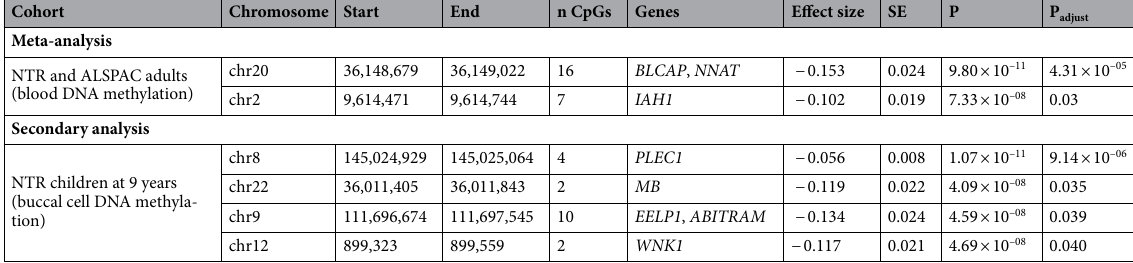
Table 4. Significant differentially methylated regions associated with left-handedness in meta-analysis and secondary analysis. Effect size is a weighted sum of the EWAS effects for each CpG site in the DMR (i.e. methylation differences between LH and RH) where the weights account for dependence between CpG sites and uncertainty in the EWAS effects (see “Methods” section). N meta-analysis = 3721, N NTR children = 866. NTR Netherlands Twin Register. ALSPAC Avon Longitudinal Study of Parents and Children. SE standard error; P adjust P -value multiplied by the total number of tests performed; the number of tests is equal to the number of regions for which DMR statistics are